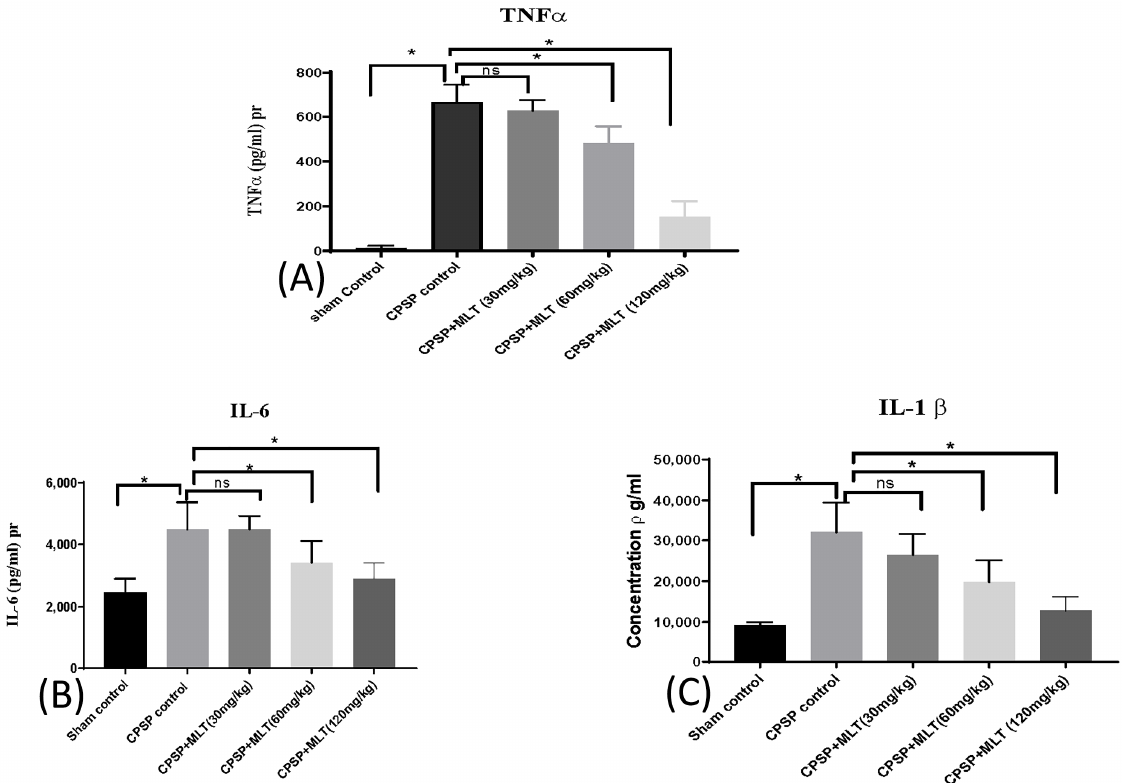
Figure 6. Effect of lesions and melatonin administration on neuroinflammation, including ( A ) TNF-a (n = 5, per group), ( B ) IL-6 (n = 6, per group), and ( C ) IL-1b (n = 6, per group) levels in the whole brain after two weeks of melatonin administration. Data expressed as mean ± SD; * p < 0.005 as compared with CPSP.